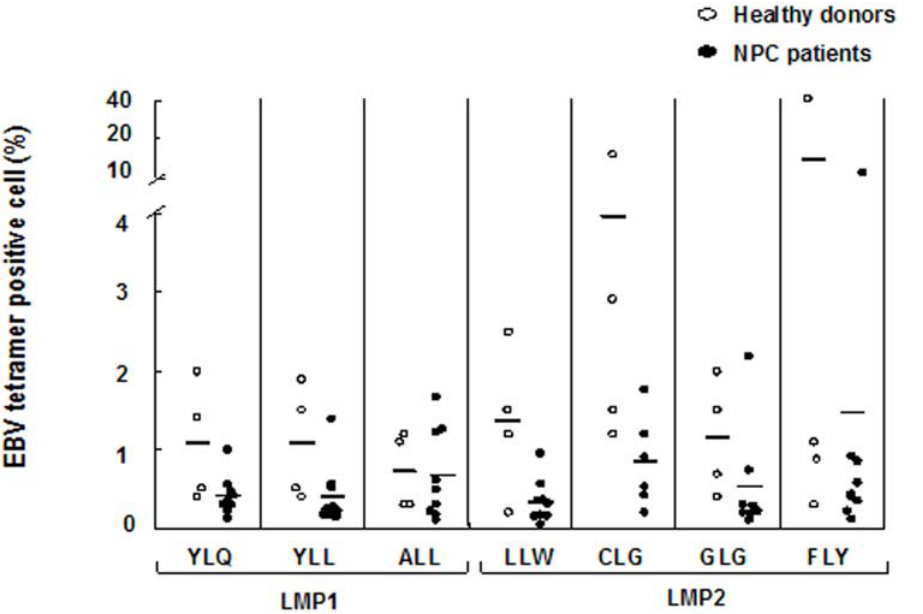
Figure 5. Frequency of LMP1 and LMP2 epitope- specific T cells in auto-LCL stimulated cultures from healthy donors and NPC patients. The frequency of T cells specific for HLA A2 restricted epitopes in LMP1 and LMP2 was detected by EBV tetramer staining and FACS analysis in auto-LCL stimulated cultures from healthy donors (n=4) and NPC patients (n=9).